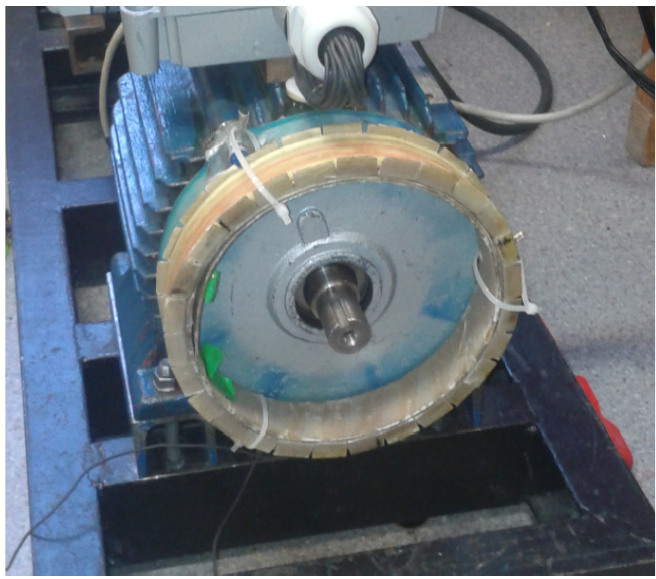
Figure 2. Stator of the examined motor with mounted coil for axial flux measurement. The method of identifying inter-turn faults presented in the paper allows for an in- depth analysis of the results obtained from measurements. During the tests the registered parameter values were used, which were obtained from laboratory measurements of the